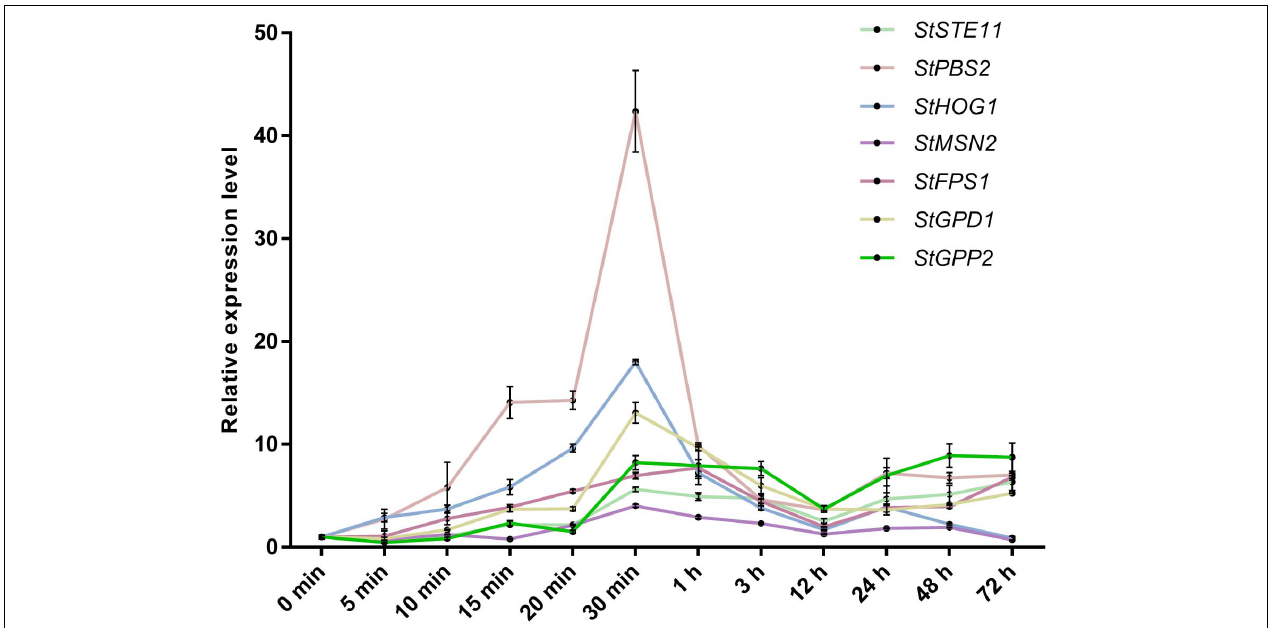
FIGURE 3 | qRT-PCR analysis of the relative expression of HOG-MAPK related genes at different treatment times in 0.4 M NaCl treatment. Data are presented as the mean ± SD of three independent